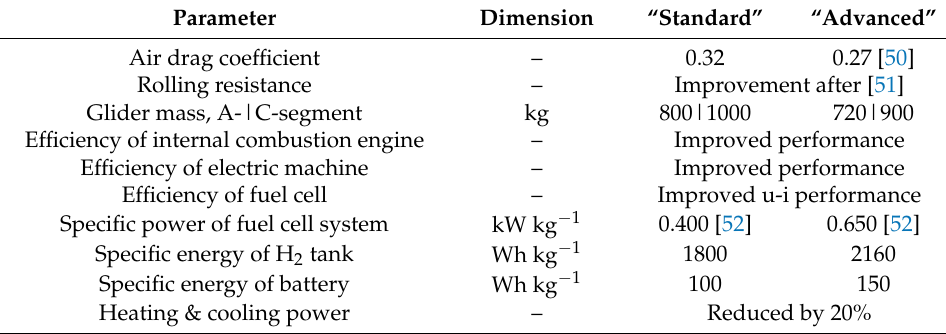
Table 12. Assumptions related to the calculation scenarios “Standard” and